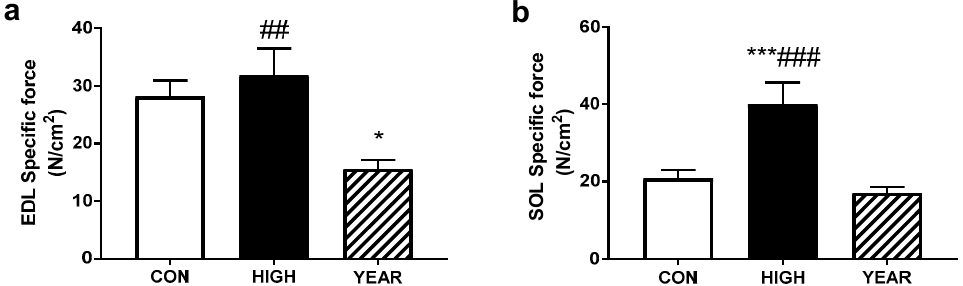
Figure 2. EDL and SOL specific force. ( a ) When the peak tetanic force was corrected for the force produced per cross sectional area (CSA), it was found that the YEAR animals displayed decreased force production in the EDL but is restored when administered in a high vitamin D diet over four weeks; ( b ) however, in the SOL, there was no effect found in the YEAR animals, instead the HIGH animals displayed increased force production when compared to both the CON and YEAR animals. Symbols indicate: * p < 0.05, *** p < 0.001; different from CON, ## p < 0.01, ### p < 0.001; different from YEAR.